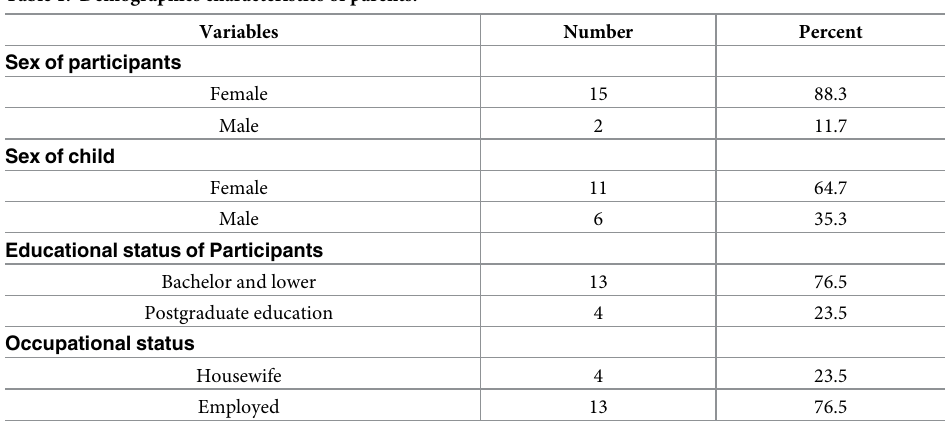
Table 1. Demographics characteristics of